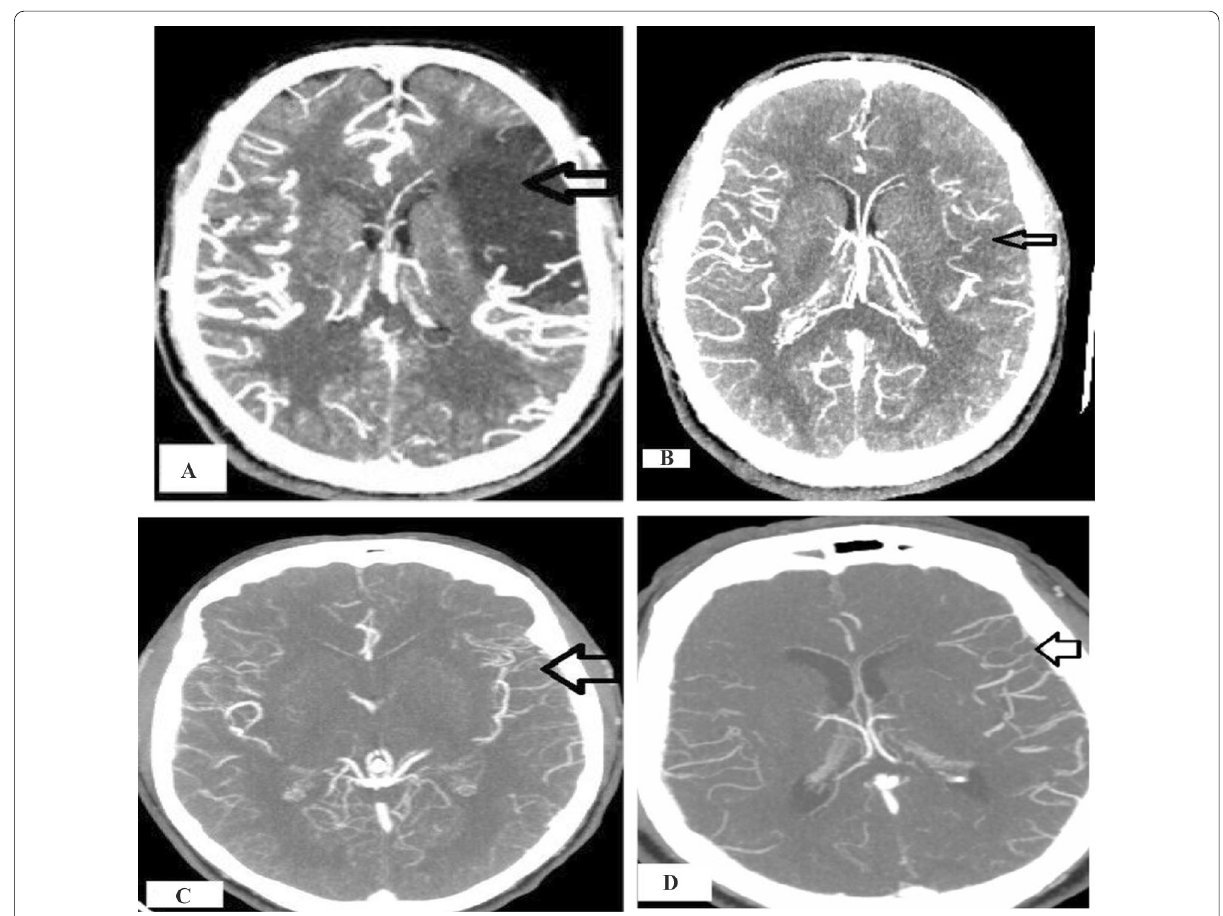
Fig. 2 Maas system. A No vessel opacification. B Opacification less than that on the contralateral side. C Opacification equal to that on the contralateral side is not shown. D More opacification than that on the contralateral